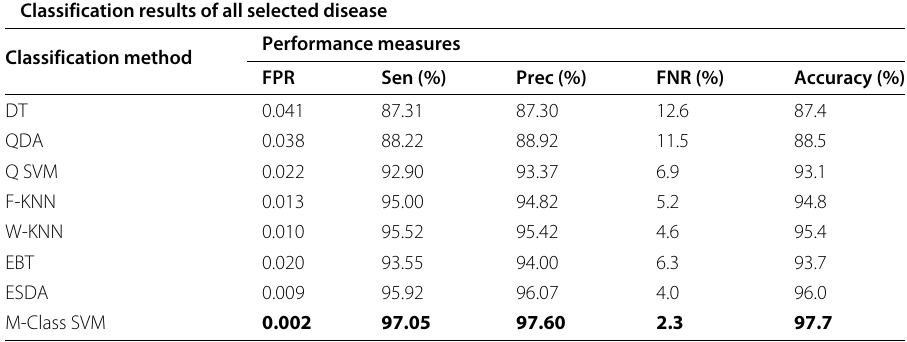
Table 12 Proposed classification results on all selected diseases Classification results of all selected disease